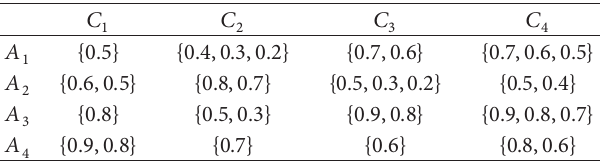
Table 3: The hesitant fuzzy decision matrix R 3 provided by decision maker 𝐷 3